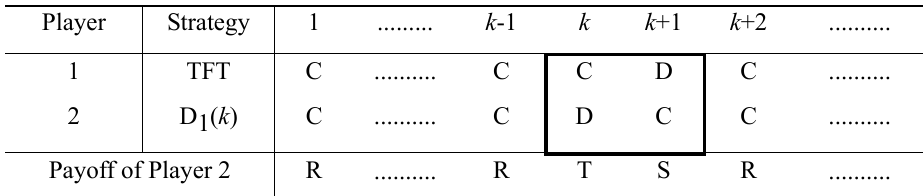
Table 3. TFT versus D1( k